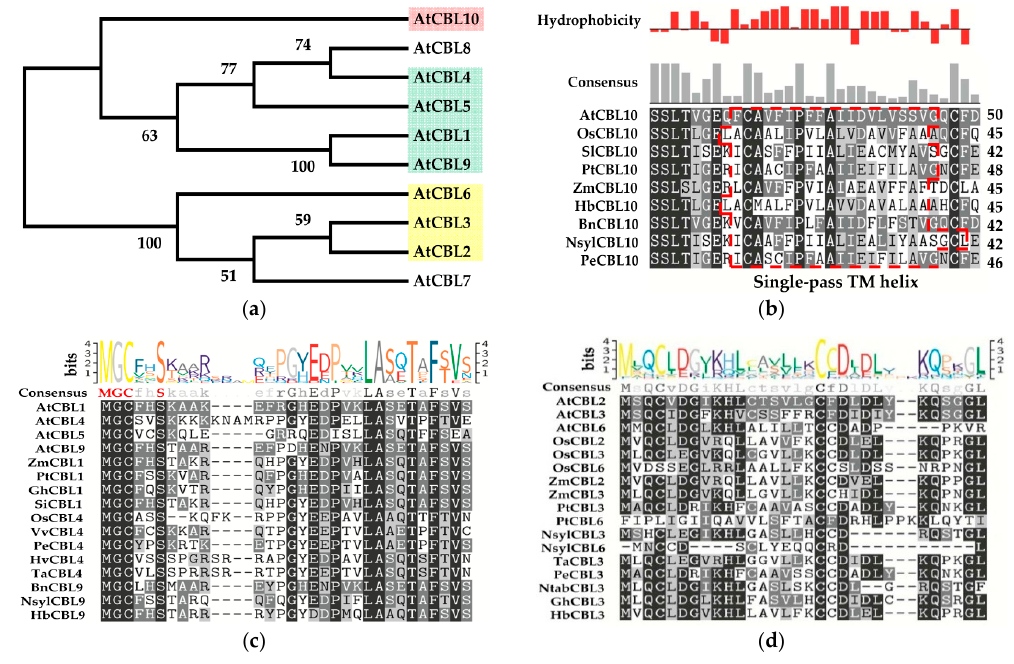
Figure 2. Classification and motifs display of CBLs. ( a ) Phylogenetic relationship of CBL proteins in Arabidopsis thaliana . The protein harboring signal-pass transmembrane (TM) helix motif, dual lipid modification MGCXXS/T motif and tonoplast targeting sequence (TTS) is marked in pink, green and yellow shades, respectively; ( b ) Detailed sequence comparisons of the single-pass TM helix of CBL10s from different plants; ( c ) Detailed sequence comparisons of the MGCXXS/T motif of CBL1, 4, 5 and 9 proteins; ( d ) Detailed comparisons of the TTS of CBL2, 3 and 6 proteins. Note: The amino acid sequences are available from UniProt (www.uniprot.org/) and we added some other CBL protein sequences from other organisms for better display. Phylogenetic tree is constructed by MEGA6 with Neighbor-Joining method. Multiple sequence alignment is provided by BoxShade (www.ch.embnet.org/software/BOX_form.html). Hydrophobicity and Consensus are indicated by Texshade. Single-pass TM helix is predicted by HMMTOP (www.enzim.hu/hmmtop/). Codification: At, Arabidopsis thalians ; Bn, Brassica napus ; Gh, Gossypium hirsutum ; Hb, Hordeum brevisubulatum ; Hv, Hordeum vulgare ; Nsyl, Nicotiana sylvestris ; Ntab, Nicotiana tabacum ; Os, Oryza sativa ; Pe,